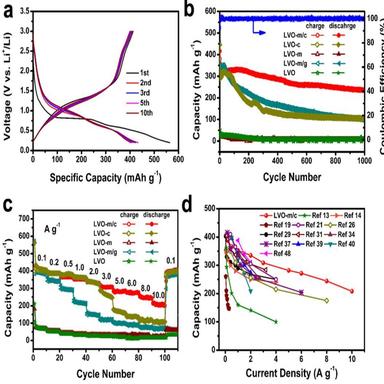
(a) Discharge/charge curves of LVO-m/c at 0.2–3.0 V. (b) Cycling performances and (c) Rate performances of LVO-m/c, LVO-c, LVO-m, LVO-m/g and LVO. (d) The comparison of LVO-m/c (our work) with other reported works in rate performance.